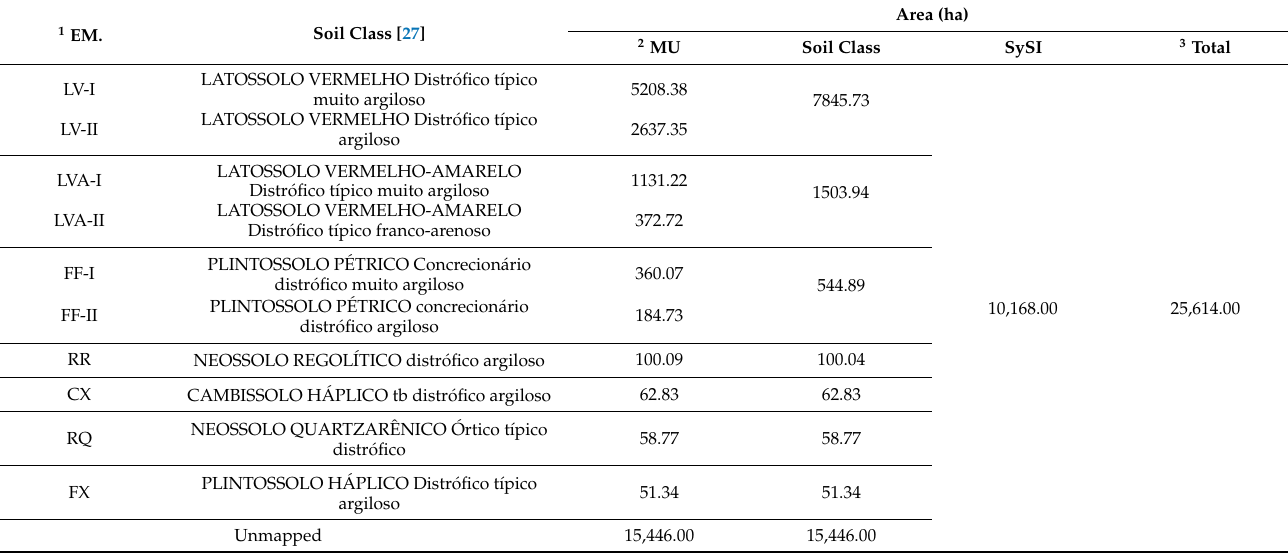
Table 3. Area of soil classes in the Riber ã o Extrema watershed (target area) digital map.